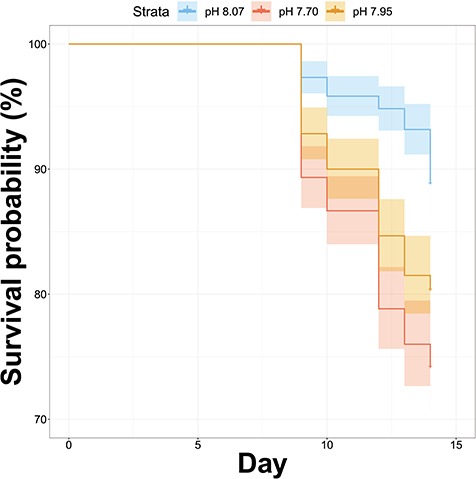
Survival Plot highlighting effect of pH treatment during the course of experiment E (+4 °C). Shaded regions represent 95% confidence intervals around the mean.